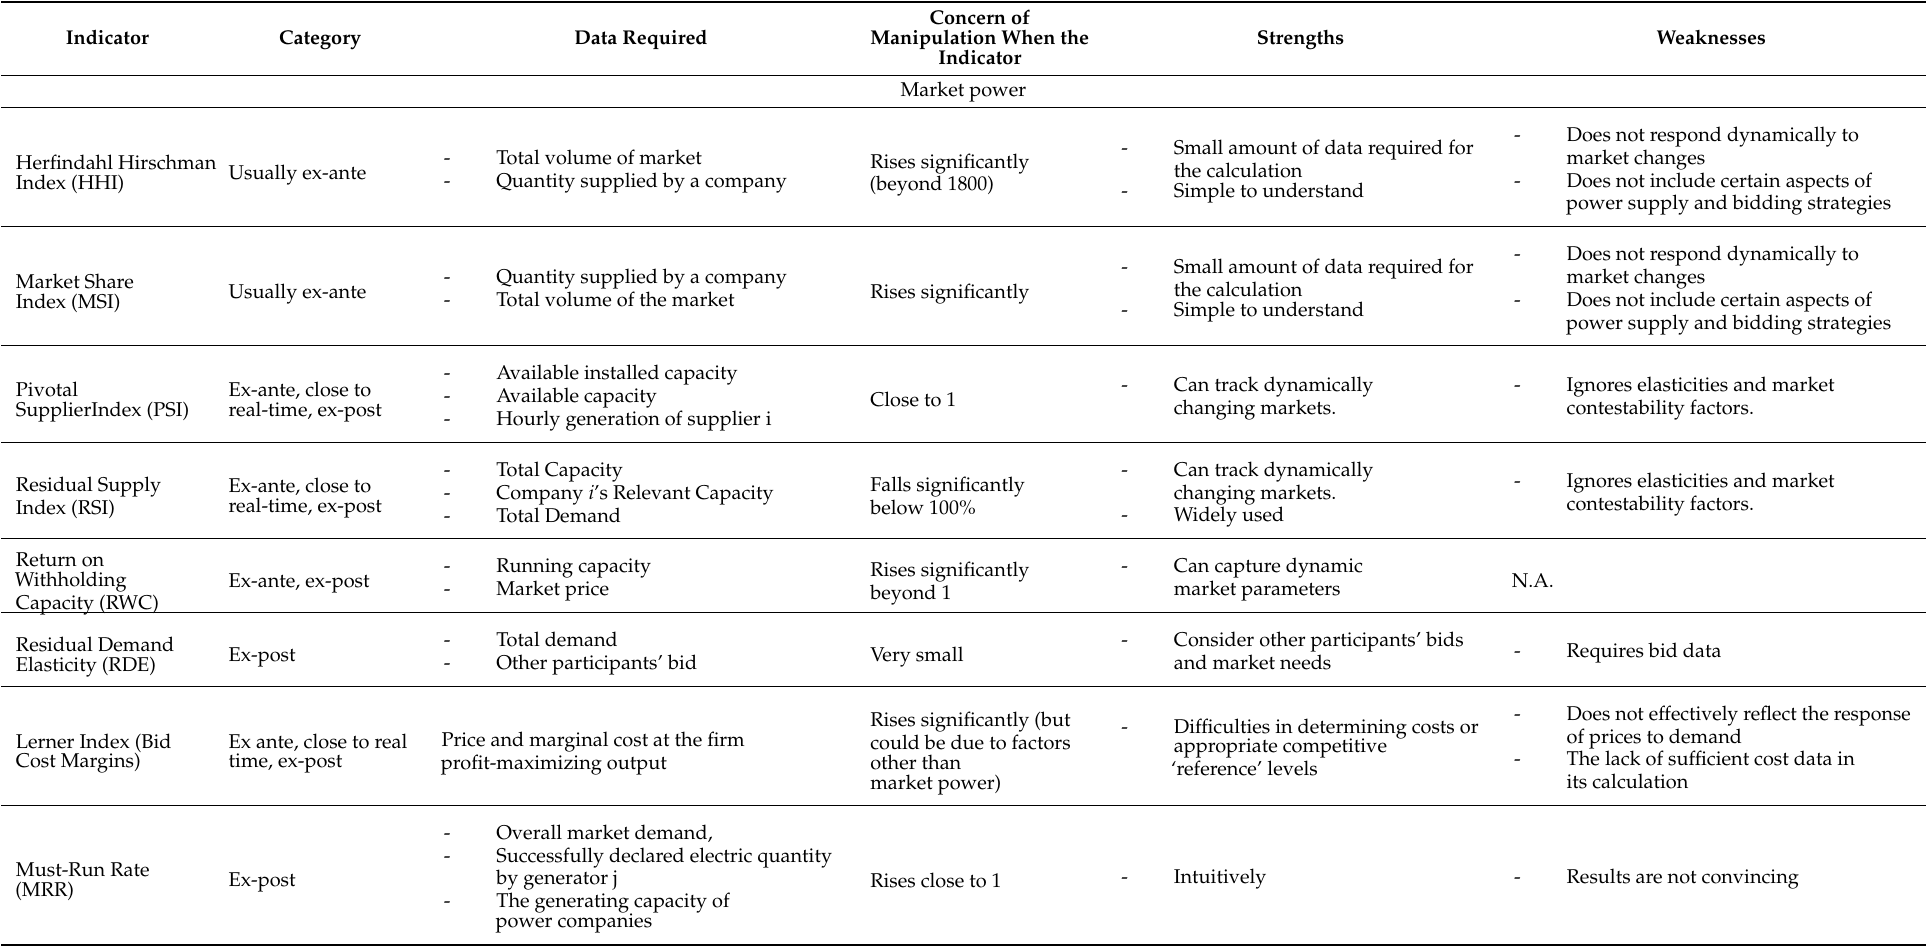
Table 4. Summary of power market monitoring indices